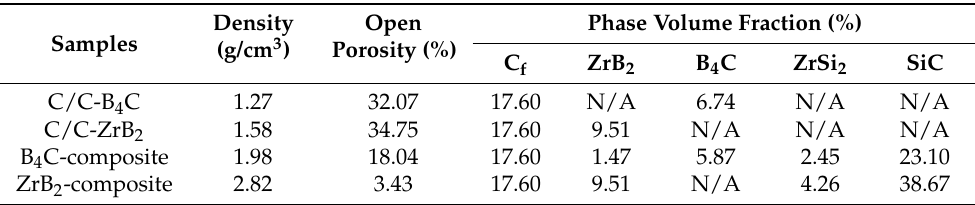
Table 1. Properties of C/C–B 4 C and C/C–ZrB 2 preforms before and after reactive melt infiltration (RMI).